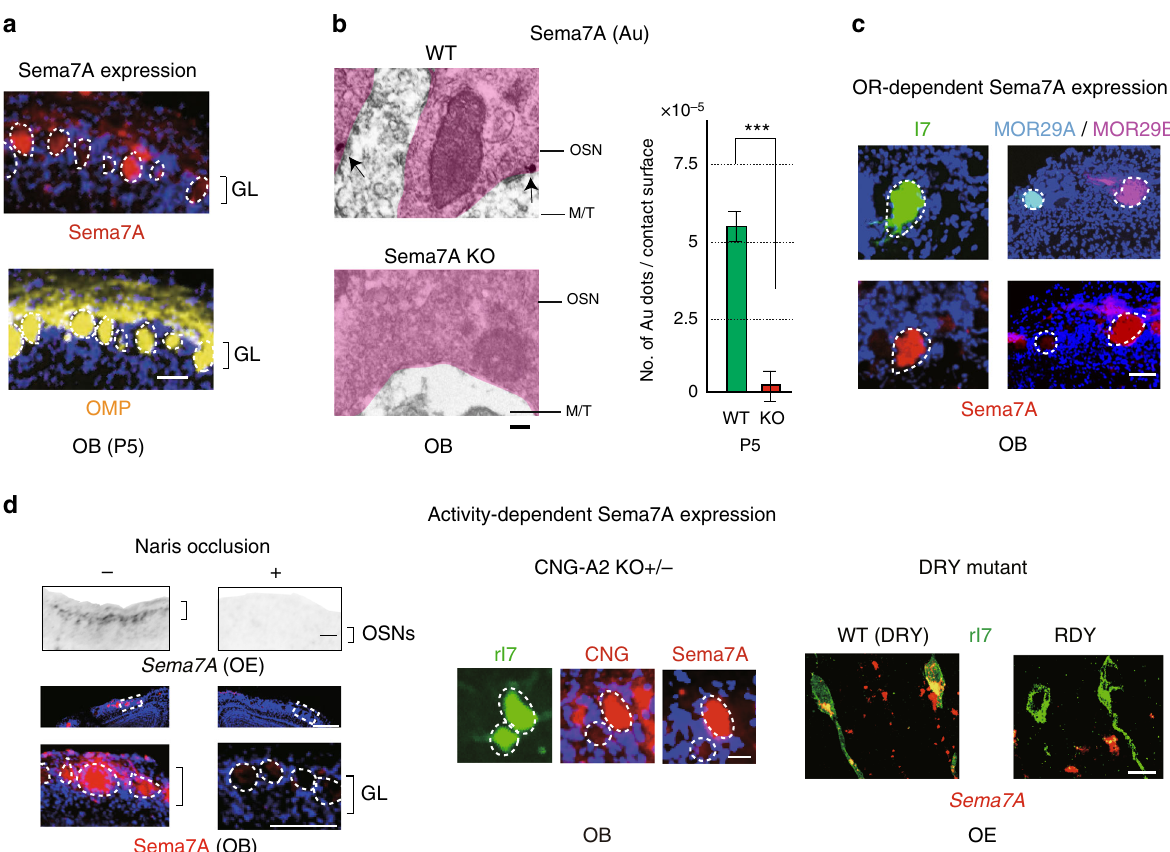
Fig. 1 Activity-dependent Sema7A expression in OSN axons. a Distribution of Sema7A in the glomerular layer of the OB. OB sections of the WT at P5 were immunostained with anti-Sema7A and anti-OMP antibodies. Scale bar = 25 μ m. b Detection of Sema7A in the axon termini of OSNs. Immuno- electronmicroscopy identi fi ed Au-labeled Sema7A (arrows) in the pre-synaptic termini of OSN axons at P5. No Au signals were detected in the Sema7A KO. The number of signals per contact surface was counted (right). *** p < 0.005 (Student ’ s t -test). Error bars indicate SD. n = 3 animals for each. Scale bar = 300 nm. c Variable expression of Sema7A among different glomeruli. OB sections at P10 were immunostained with anti-Sema7A antibodies. EYFP- tagged rI7, ECFP-tagged MOR29A and EYFP-tagged MOR29B glomeruli were detected by immunostaining with anti-GFP antibodies. Scale bar = 25 μ m. d Activity-dependent Sema7A expression. Left, Down-regulation of Sema7A expression by uni-lateral naris occlusion. Mice were unilaterally occluded at P0. OE sections (P6) were analyzed by in situ hybridization. OB sections (P6) were analyzed by immunostaining with anti-Sema7A antibodies. ( + ) occluded, ( − ) unoccluded. Scale bars, 50 (upper), 100 (lower) μ m. Middle, CNG-channel-dependent Sema7A expression. Duplicated glomeruli of rI7 in the heterozygous CNG-A2 KO were analyzed for Sema7A expression at P5. EYFP-tagged rI7 glomeruli were detected by immunostaining with anti-GFP antibodies. OB sections were immunostained with antibodies against CNG-A2 and Sema7A. Scale bar = 25 μ m. Right, OR-activity dependent Sema7A expression. A DRY-motif mutant of rI7 suppresses Sema7A expression because it does not generate cAMP. OE sections expressing the WT rI7 and DRY- motif mutant (RDY) were analyzed by in situ hybridization for Sema7A expression at P5. OSNs expressing the EYFP-tagged rI7 were detected